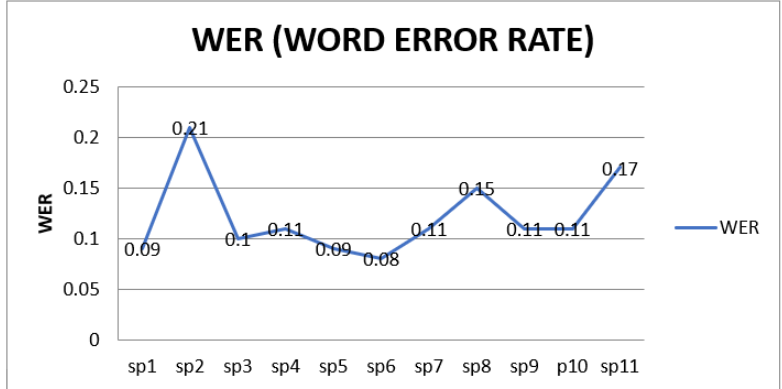
Figure 5. Graph depiction for WERs for all input files (Speakers